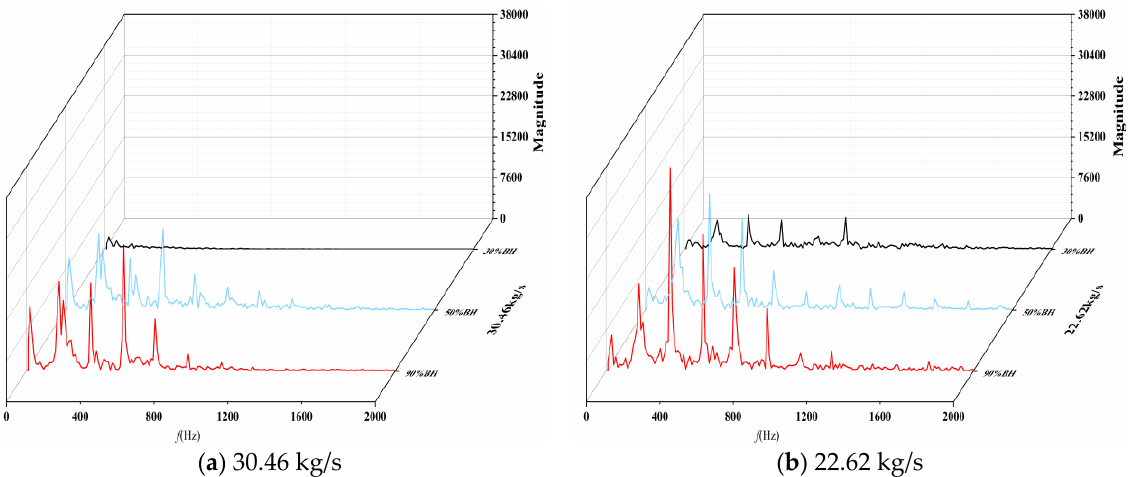
Figure 13. Amplitude spectra of monitoring point at different blade heights (30%,50%,90%) in off- design